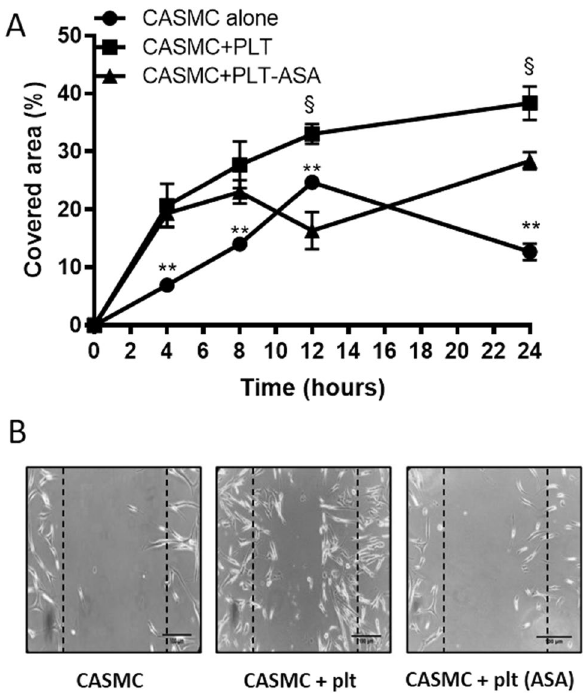
Figure 3. Effects of platelets on CASMC migration. ( A ) Human CASMC (0.8 × 10 5 cells) were cultured alone or cocultured with human platelets (0.5 × 10 8 ) (pretreated or not with Aspirin, ASA, 100 µM) for 20 h and cell migration of confluent cells was evaluated at different time-points (up to 24 h) by scrape wounding assay, using an inverted microscope and a digital camera (original magnification × 10), the dashed lines indicate the starting position of the cell migration occurring toward the center of the wound; % of covered area values are reported as mean ± SEM, n = 3 (separate experiments), the scale bar is of 100 µm. In each experimental condition, % covered area was significantly different ( P < 0.01) at each time-point versus time 0 (using two-way ANOVA, Dunnett’s multiple comparisons test), not shown. At 4 h, ** P < 0.01, CASMC alone versus CASMC + PLT and CASMC + PLT-ASA; at 8 h, ** P < 0.01, CASMC alone versus CASMC + PLT and CASMC + PLT-ASA; at 12 h, ** P < 0.01, CASMC alone versus CASMC + PLT and CASMC + PLT-ASA, § P < 0.01, CASMC + PLT versus CASMC + PLT-ASA; at 24 h, ** P < 0.01, CASMC alone versus CASMC + PLT and CASMC + PLT-ASA, § P < 0.01, CASMC + PLT versus CASMC + PLT-ASA (using two-way ANOVA, Tukey’s multiple comparisons test). ( B ) The results of cell migration obtained at 24 h are